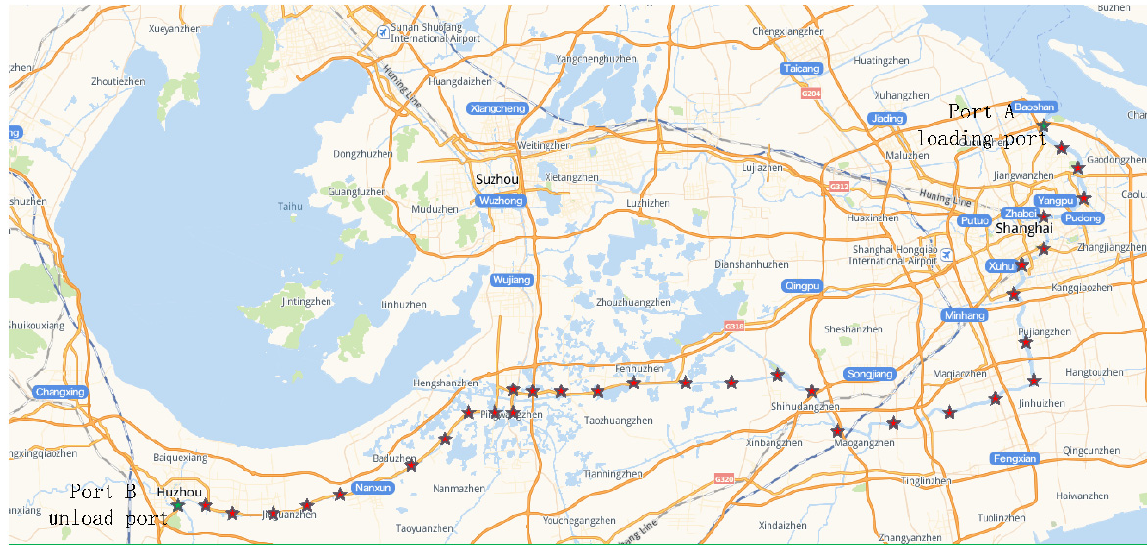
167.01 Table 2. Parameters of a battery-powered bulk freighter ship. Parameters